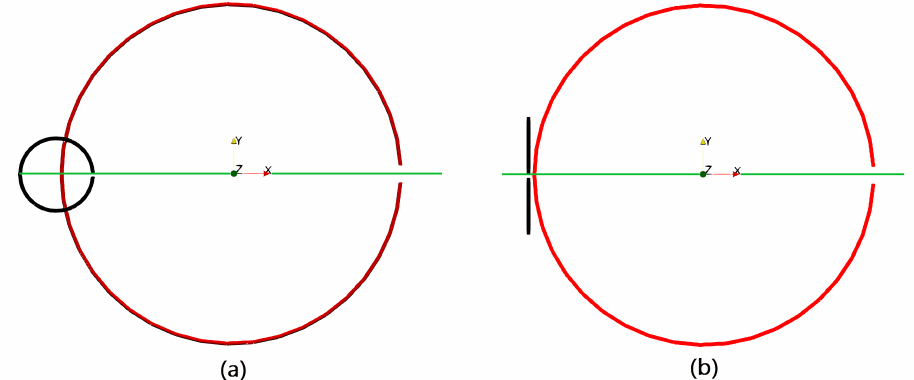
Figure 25. Simulation setup for the coupling investigations. For both setups, a C = 0.45 λ loop antenna (red) is placed in the xy-plane. The feed-gap is placed in the φ = 0-direction. In ( a ), an electrically small loop antenna is placed parallel to the big loop with a z-distance of 0.05 λ . In ( b ), a y-orientated electrically small dipole antenna is placed above the big loop antenna, with a z-distance of 0.05 λ . The small loop ( a ) and small dipole ( b ) are placed along the green line to analyze the coupling behavior for different points.